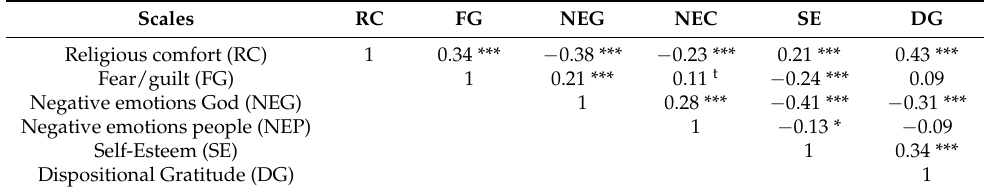
Table 2. Pearson’s correlation results for all measured variables. Scales